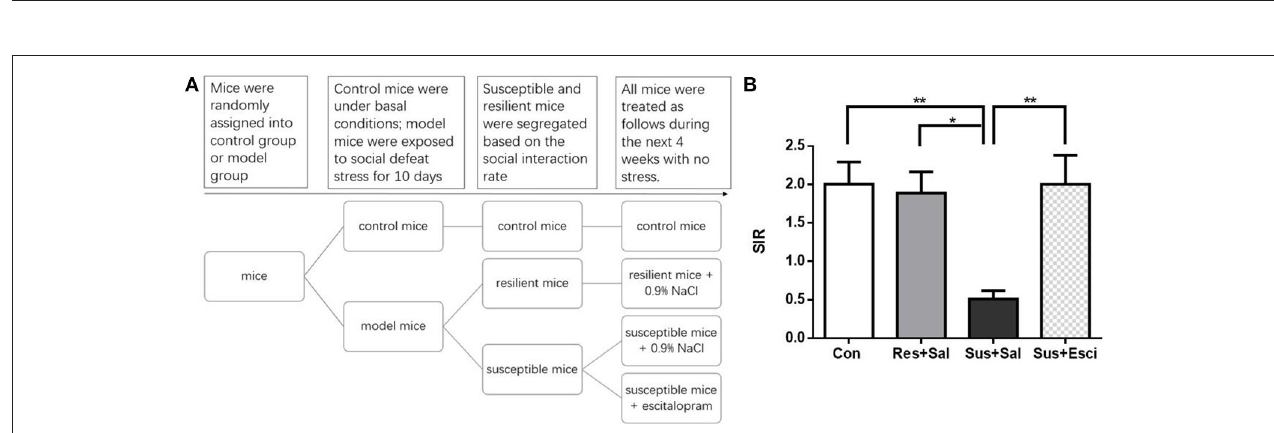
FIGURE 4 | Escitalopram could counteract the social avoidance behavior. (A) The experimental procedure of the second and third experiment. (B) The social interaction rate in the social interaction test after 4 weeks treatment [ n (Con) = 20; n (Res + Sal) = 12; n (Sus + Sal) = 13; n (Sus + Esci) = 16]. All data are shown as mean ± s.e.m. * P < 0.05, ** P < 0.01. Con, Control; Res + Sal, Resilient + Saline; Sus + Sal, Susceptible + Saline; Sus + Esci, Susceptible + Escitalopram.